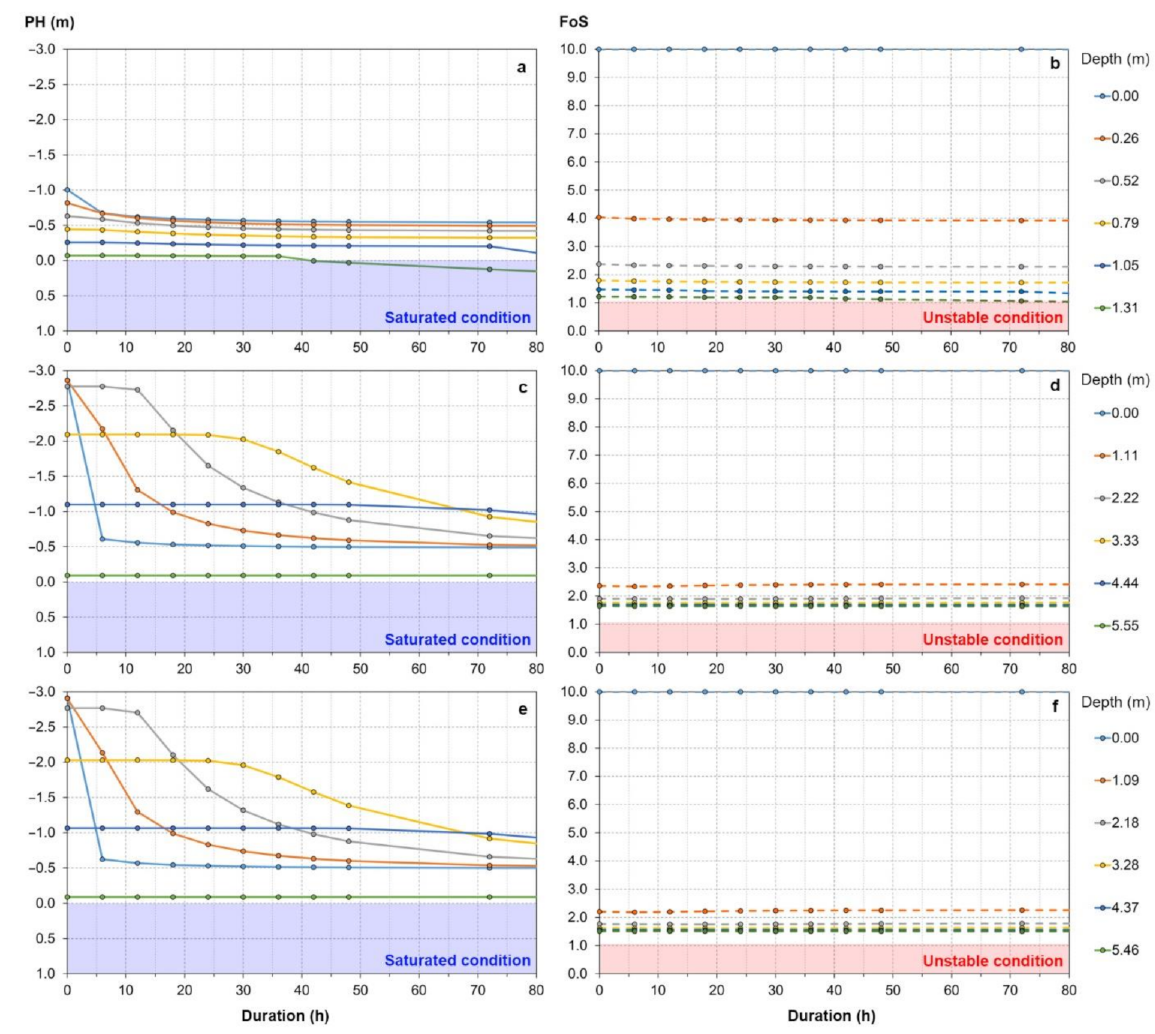
Figure 6. Example of modeled Pressure Head (PH; a , c , e ) and Factor of Safety (FoS; b , d , f ) time series at different depths for each sample cell (1, 2, 3 in Figure 5). Results shown are related to 2.5 mm/h of rainfall intensity